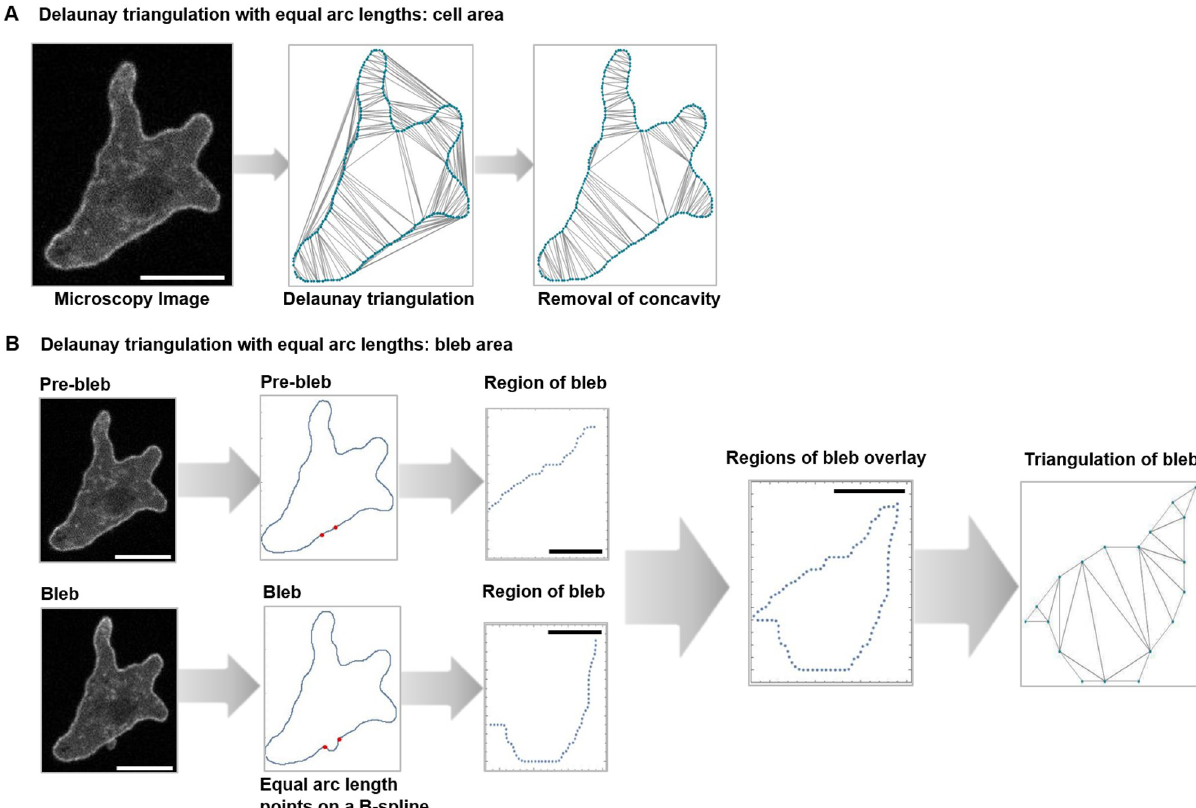
Fig 7. Applying Delauney triangulation to determine cell and sub cellular areas. (A) The area of a cell. A cell triangulated by the Delaunay procedure. The convex hull is included within the triangulation. The image on the right shows the result of removing the external triangles. The sum of the triangle areas in this image estimates the cell area. (B) The area of a belb. The two images on the left show the cell before and after the bleb. The next pair (above and below) show the cell by plotting the equi-spaced list of points on the boundary. On the right we see the region of the bleb before and after the event. These two images are overlaid in the lower right. This is a geometric view of the bleb. Finally, we have triangulated the bleb in preparation to estimating its area. Large scale bars identify 10 micron lengths; small scale bars identify 1 micron.